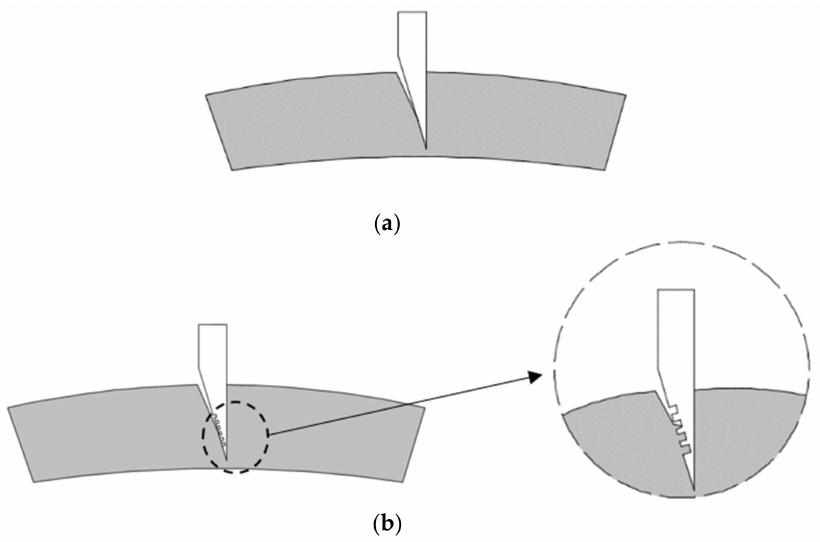
Figure 27. The cutting process of ordinary pruners and micro-textured pruners: ( a ) the cutting process of ordinary pruners; ( b ) the cutting process of textured